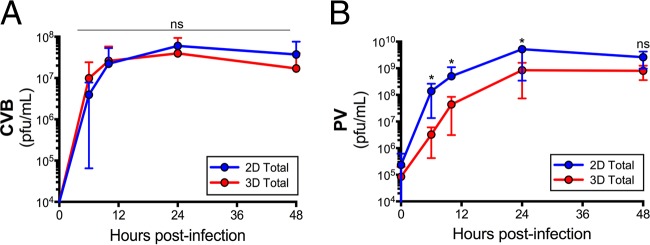
(A) CVB titers (in PFU/milliliter) of virus collected from the medium of 2-D or 3-D cultures of HeLa cells infected with CVB (1 PFU/cell) for the indicated hours postinfection. (B) PV titers (in PFU/milliliter) of virus collected from the medium of 2-D or 3-D cultures of Caco-2 cells infected with PV (3 PFU/cell) for the indicated hours postinfection. Data are shown as means ± standard deviations and are averaged from three independent STLVs. Values that are significantly different (P < 0.05) by a Student’s t test are indicated by an asterisk. Values that are not significantly different (ns) by a Student’s t test are also indicated.